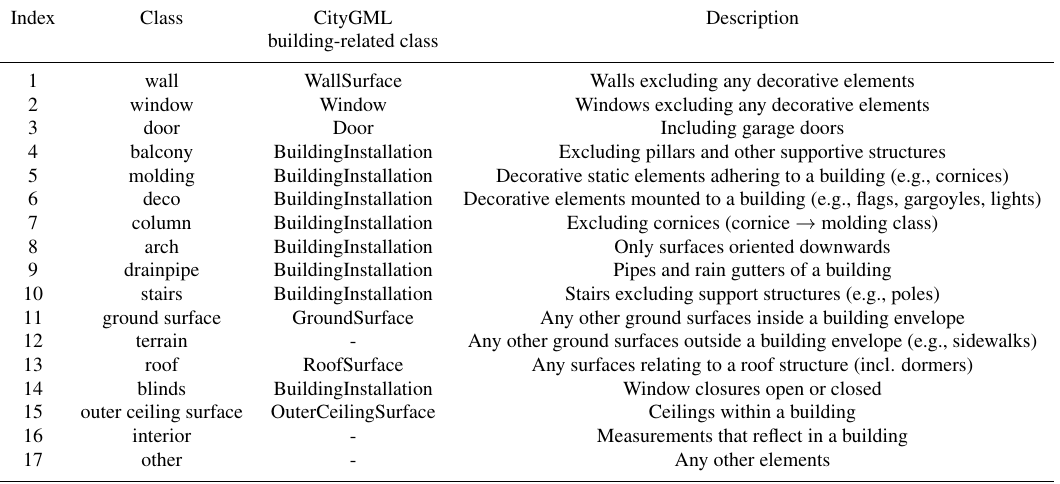
Table 1. Our proposed classes for point cloud benchmark datasets to facilitate testing of fac¸ade segmentation